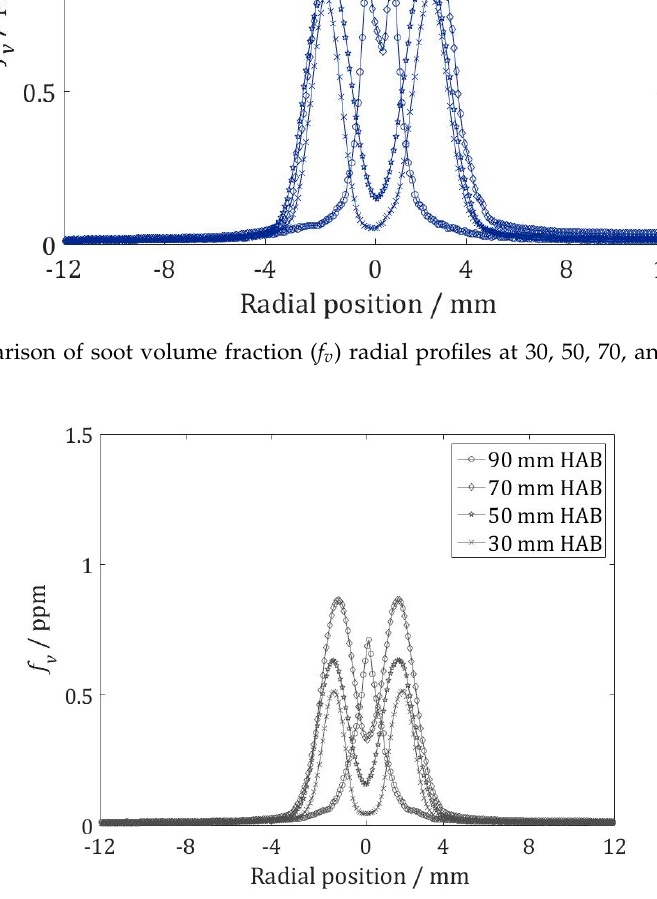
Figure 9. Comparison of soot volume fraction ( f v ) radial profiles at 30, 50, 70, and 90 mm for the baseline diesel.